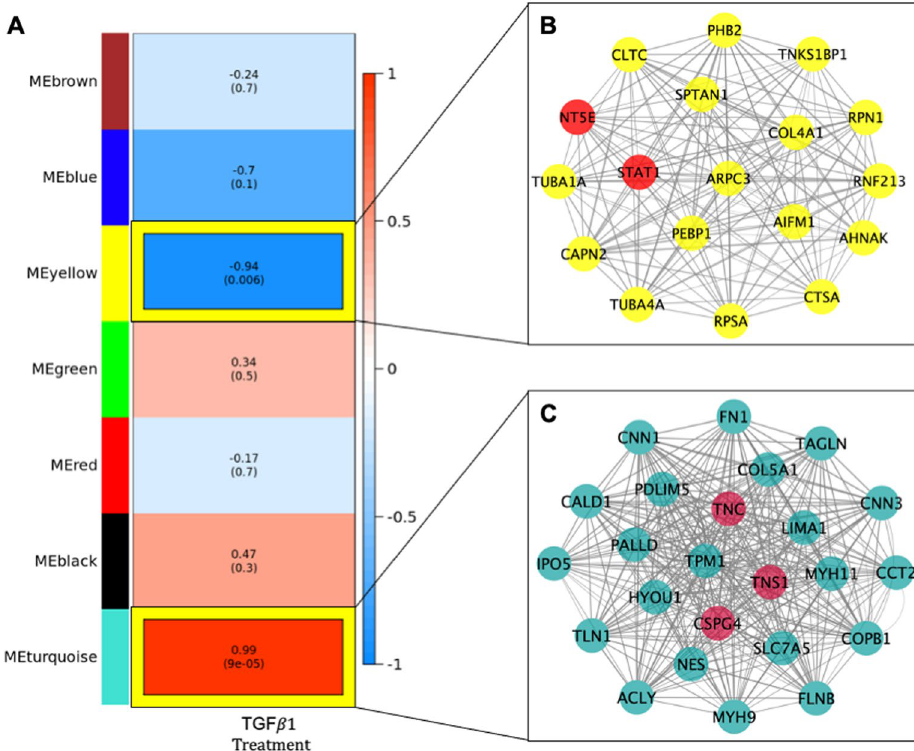
Figure 2. Weighted gene co-expression network analysis of proteomic data generated from IMR-90 cells with and without TGFβ treatment. ( A ) Proteomic Modules Associated with TGFB1 Treatment in IMR-90 cells. Values represent correlation with p-values in parentheses between each module and trait. Heatmap shading corresponds to strength of association where darker red cells have higher upregulation and darker blue cells have higher downregulation based on correlation. Text outlined in yellow denotes result withstands Bonferroni correction for multiple testing based on the number of modules generated. ( B , C ) Network of hub proteins in proteomic modules significantly associated with TGFβ Treatment. Proteins with a kME larger than 0.90 were selected for visualization in the turquoise ( B ) and yellow ( C ) modules. The size of the circle in each network corresponds to increasing module membership and the thickness of the edge corresponds to increasing topological overlap (TOM), a measure of the strength of correlation between protein levels, which is the Pearson’s correlation obtained from the adjacency matrix. Yellow nodes correspond to significant single proteins in the turquoise module associated with TGFβ1 treatment. Red nodes correspond to known targets of pirfenidone and/or nintedanib.